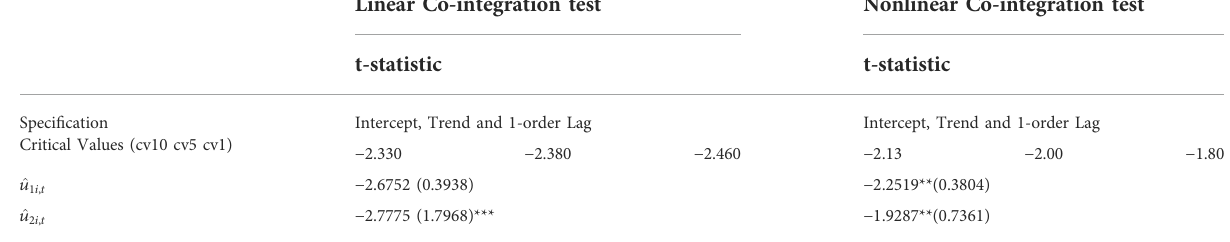
TABLE 3 Panel co-integration test